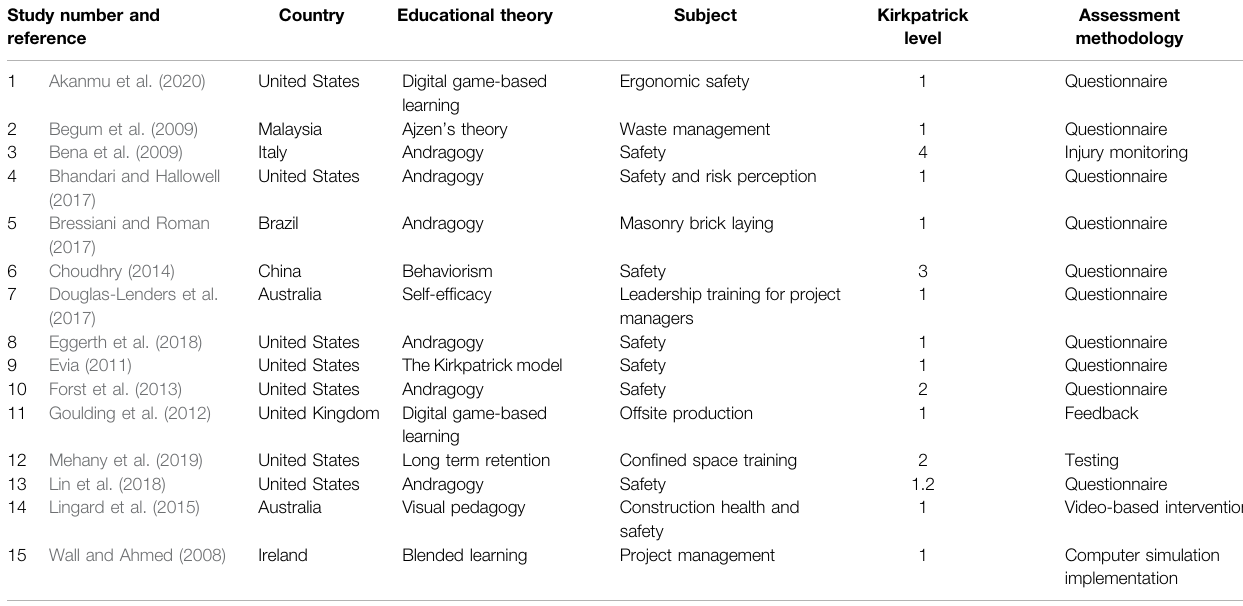
TABLE 1 | Construction industry training studies reviewed.